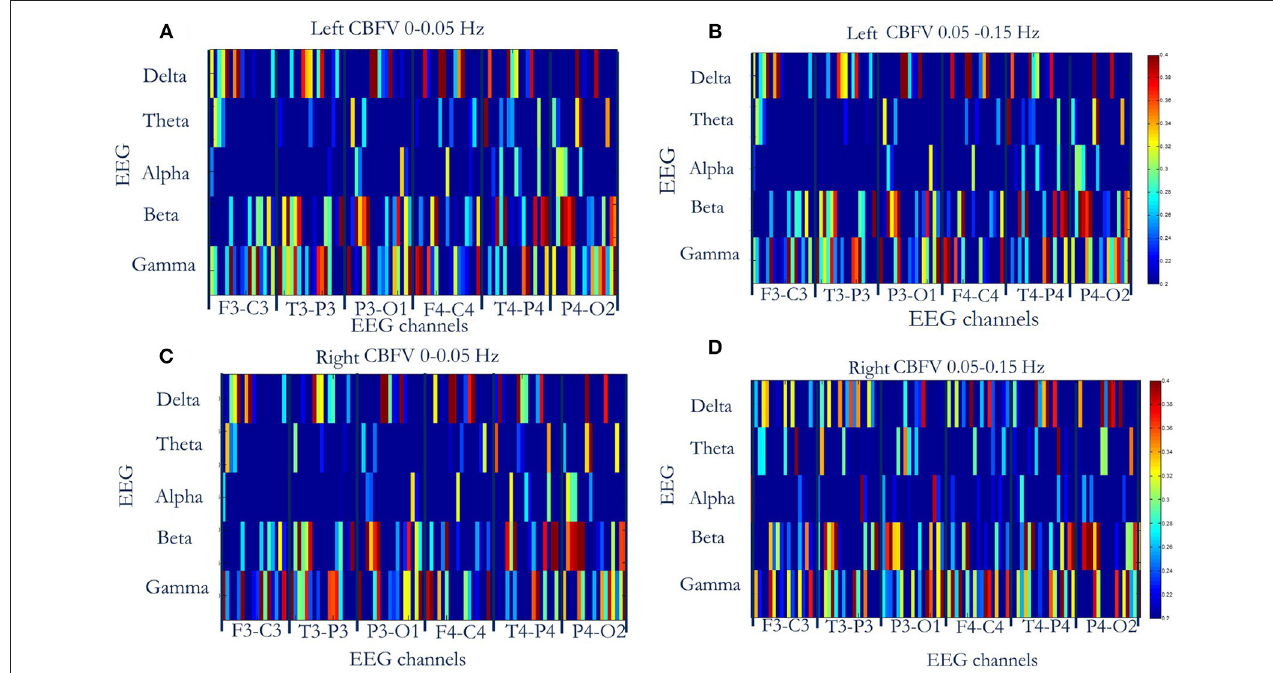
FIGURE 2 | Phase-amplitude cross-frequency coupling (PAC) between CBFV and EEG of six channels (F3-C3, T3-P3, P3-O3, F4-C4, T4-P4, P4-O2) of all the 16 patients. The x axis represents six EEG channels, and the y axis represents five EEG bands. Each subfigure represents CBFV of one side in one frequency ( A , C : 0 ∼ 0.05Hz and B,D :0.05 ∼ 0.15Hz), and one dot represents one patient, with red color indicating strong PAC and blue color indicating weak PAC. In general, PAC between CBFV and EEG in β and γ bands show brighter belt, indicating stronger PAC in these two bands than the other three EEG bands. (A) PAC between phase of left CBFV (0–0.05Hz) and amplitude of EEG (six channels, five bands). (B) PAC between phase of left CBFV (0.05–0.15Hz) and amplitude of EEG. (C) PAC between phase of right CBFV (0–0.05Hz) and amplitude of EEG. (D) PAC between phase of right CBFV (0.05–0.15Hz) and amplitude of EEG. CBFV, cerebral blood flow velocity; ABP, arterial blood pressure; EEG,